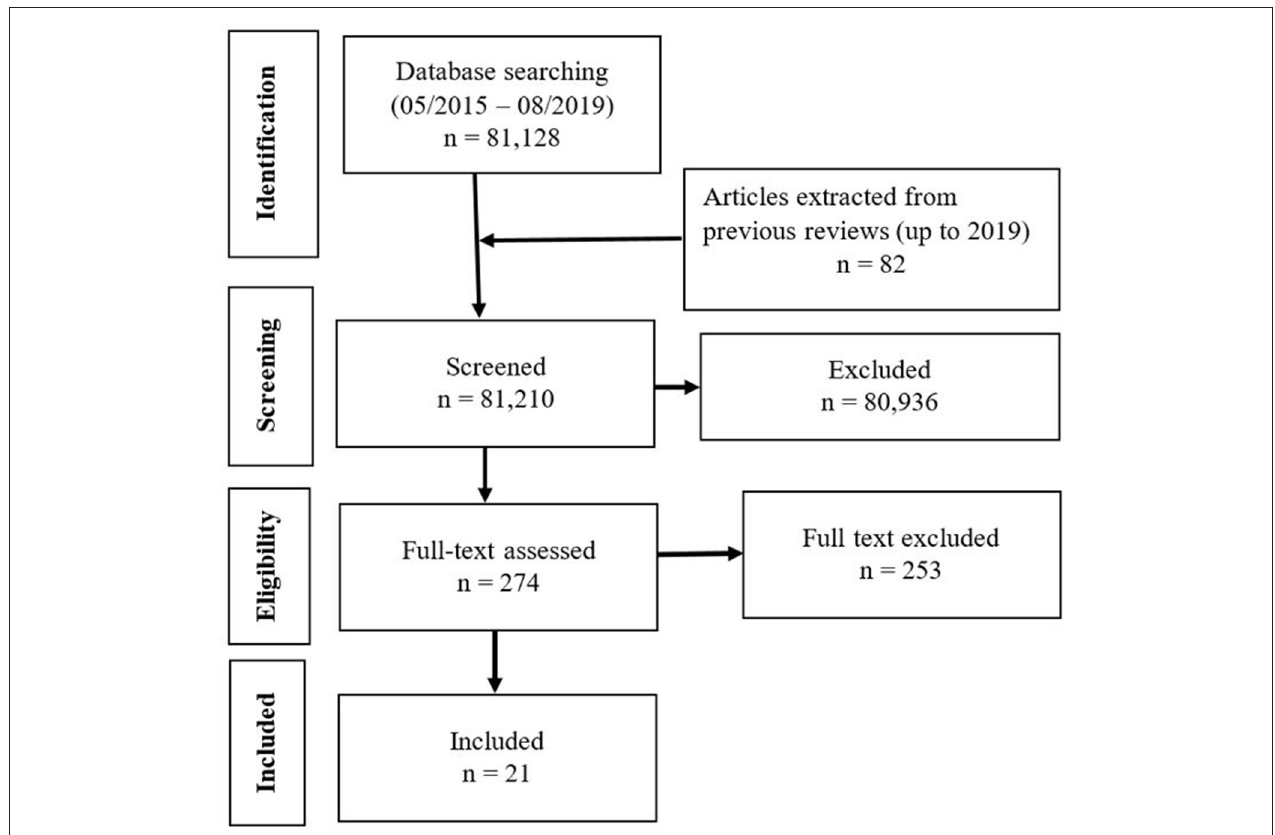
FIGURE 1 | Flow chart showing the selection of